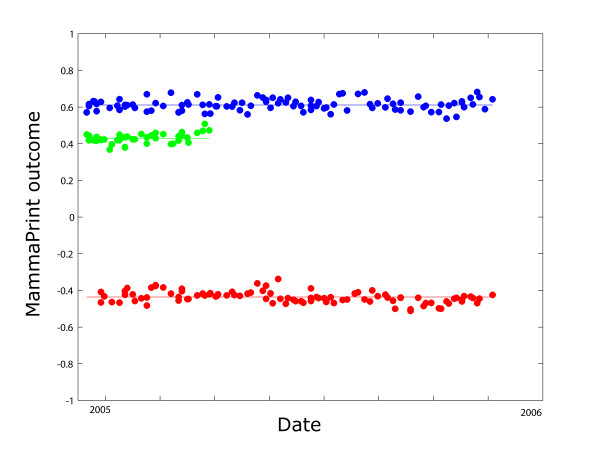
Custom diagnostic microarray outcome of two samples over time. The correlation to the good prognosis profile of three samples (HRC, LRC, and BLS) of >100 measurements over a period of 12 months shows constant outcome.